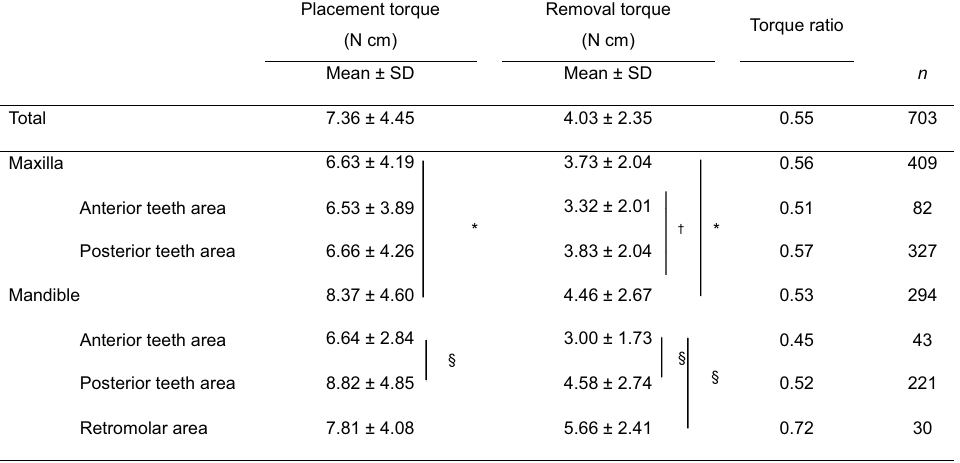
Table 2 Placement and removal torque values in terms of placement sites Placement torque